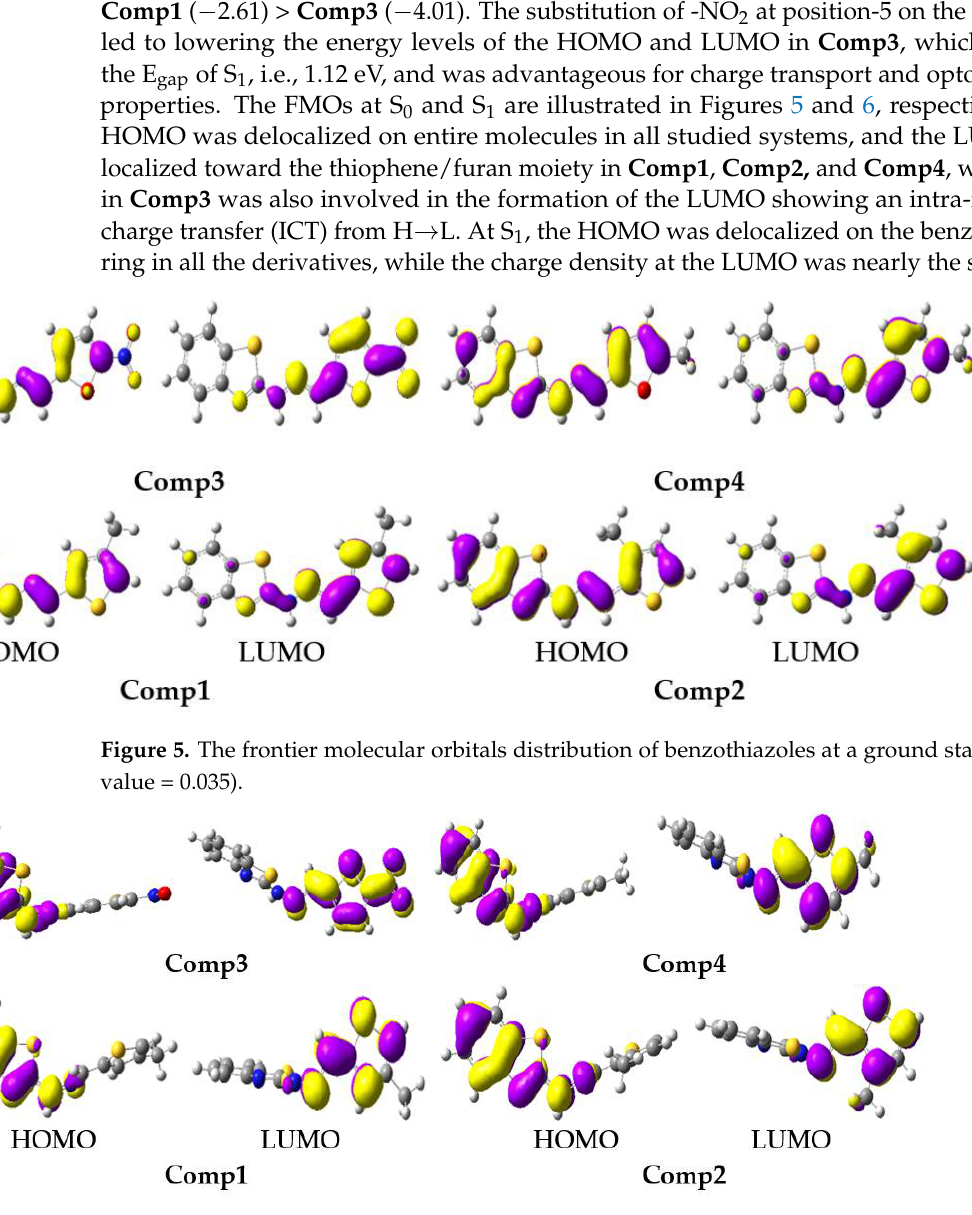
Figure 6. The frontier molecular orbitals distribution of benzothiazoles in an excited state (contour value = 0.035).